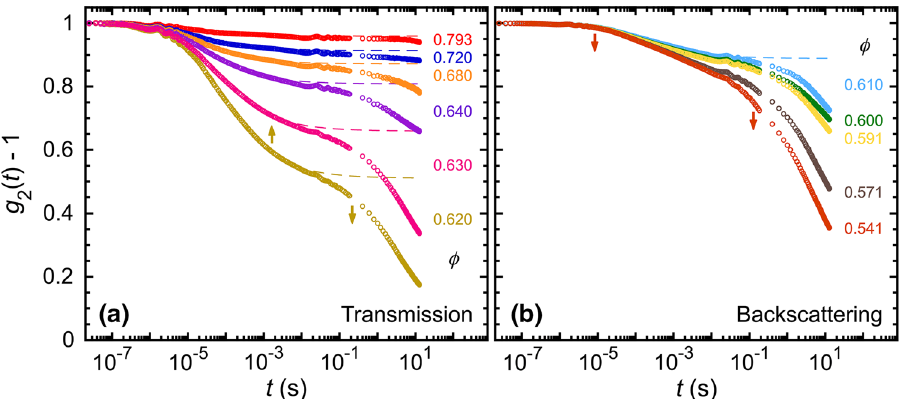
Figure 2. Measured time-dependent DWS intensity autocorrelation functions, g 2 ( t ) − 1 , of intermediately attractive O/W emulsions for dense droplet volume fractions φ (color-coded, see right), measured in ( a ) transmission and ( b ) backscattering geometries, respectively (pathlength L = 5 mm, light wavelength (cid:31) = 685 nm). DWS multi-tau correlation data extend from early times up to about 2 × 10 − 1 s; DWS echo data are shown at longer times. Arrows indicate the sign of concavity in the linear-log plot (up = +, down = −): [part (a)] for φ = 0.620, g 2 ( t ) − 1 is concave up at earlier times, then concave down at longer times; [part (b)] by contrast, at lower φ = 0.541, no concave up region is observed (both arrows are down). Dashed lines correspond to the calculated primary decay-to-plateau g 2 ( t ) − 1 using the fitting parameters obtained from the fits in Fig. 3a. Minor damped oscillatory noise signals, resulting from minute mechanical vibrations, are superimposed on the main g 2 ( t ) − 1 signals, and visible for all φ at 3 × 10 − 7 s (cid:31) t (cid:31) 10 − 5 s and 5 × 10 − 3 s (cid:31) t (cid:31) 2 × 10 − 1